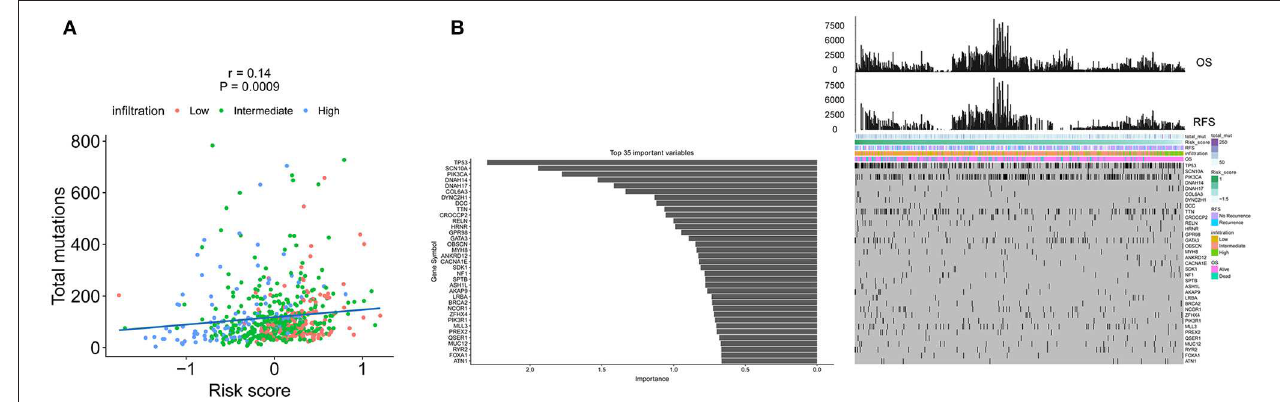
FIGURE 6 | The association of the immune signature with cancer somatic mutations. (A) The correlation between the immune signature and IDC somatic mutations. (B) Distribution of somatic mutations correlated with the immune signature. The upper bar plot indicates OS and RFS per patient, whereas the left bar plot shows the importance of the somatic mutations correlated with the immune signature. IDC, invasive ductal carcinoma; OS, overall survival; RFS, recurrence-free survival.